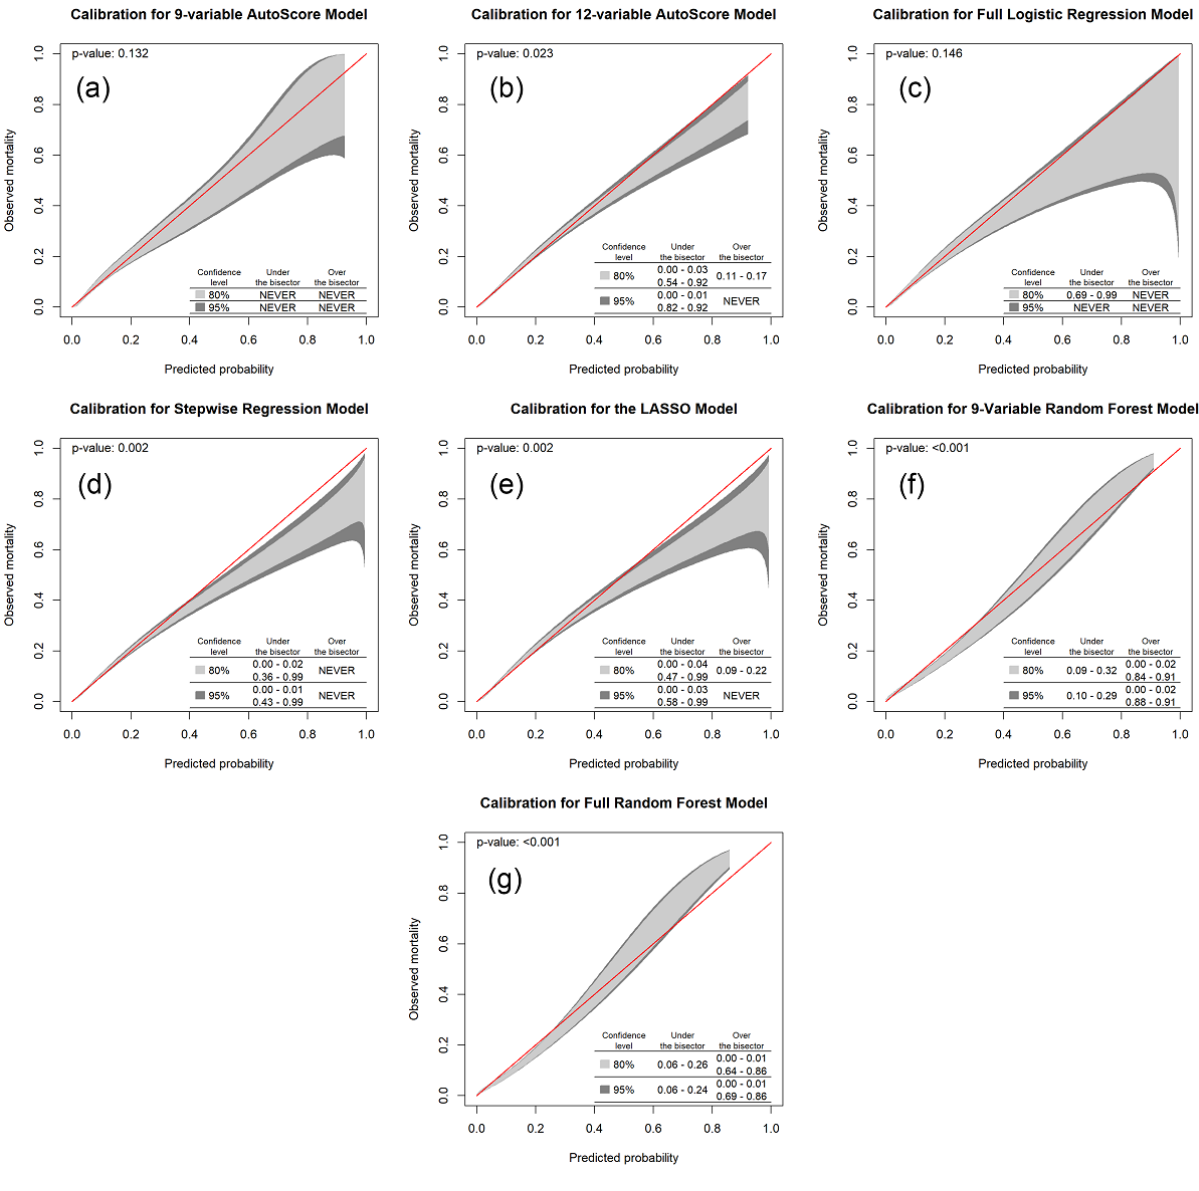
Figure 5. Calibration belts (at 80% and 95% confidence levels) for (a) a nine-variable AutoScore-created model, (b) a 12-variable AutoScore-created model, (c) a full logistic regression model, (d) a stepwise regression model, (e) the LASSO model, (f) a nine-variable random forest model, and (g) a full random forest